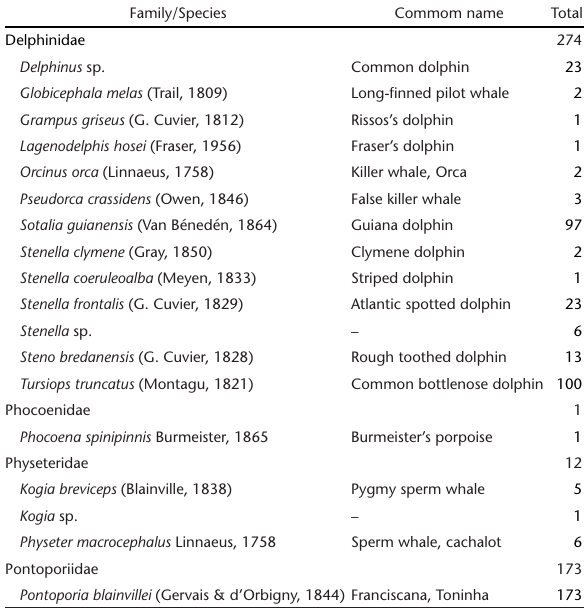
Table 1. Number of strandings of odontocete cetaceans recorded in the Santa Catarina coast, southern Brazil, from 1983 to 2014. Species names follow the C ommittee on t axonomy